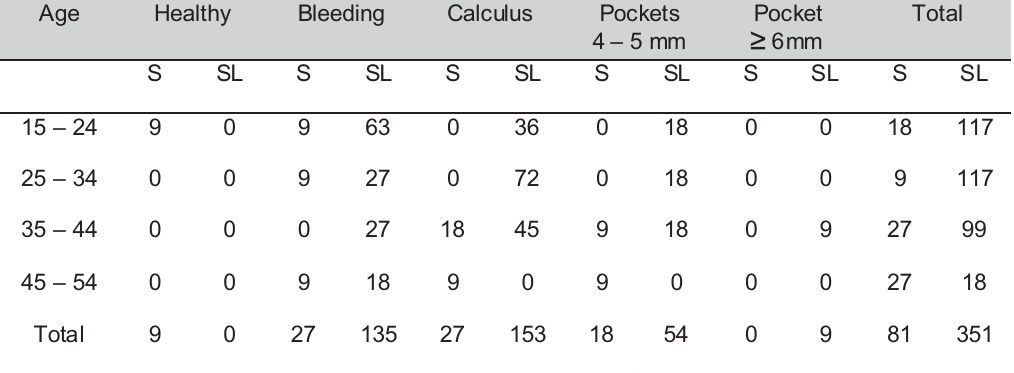
Table 3 - Distribution of smokers (S) and smokeless (SL) tobacco users in accordance with CPI scores in different age groups